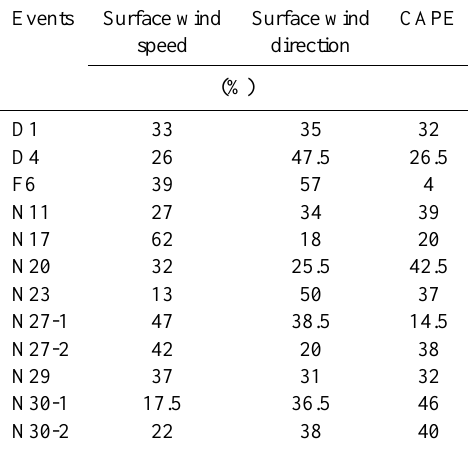
Table 2. Percentage of influence for the meteorological parameters on the convective development of the Hector